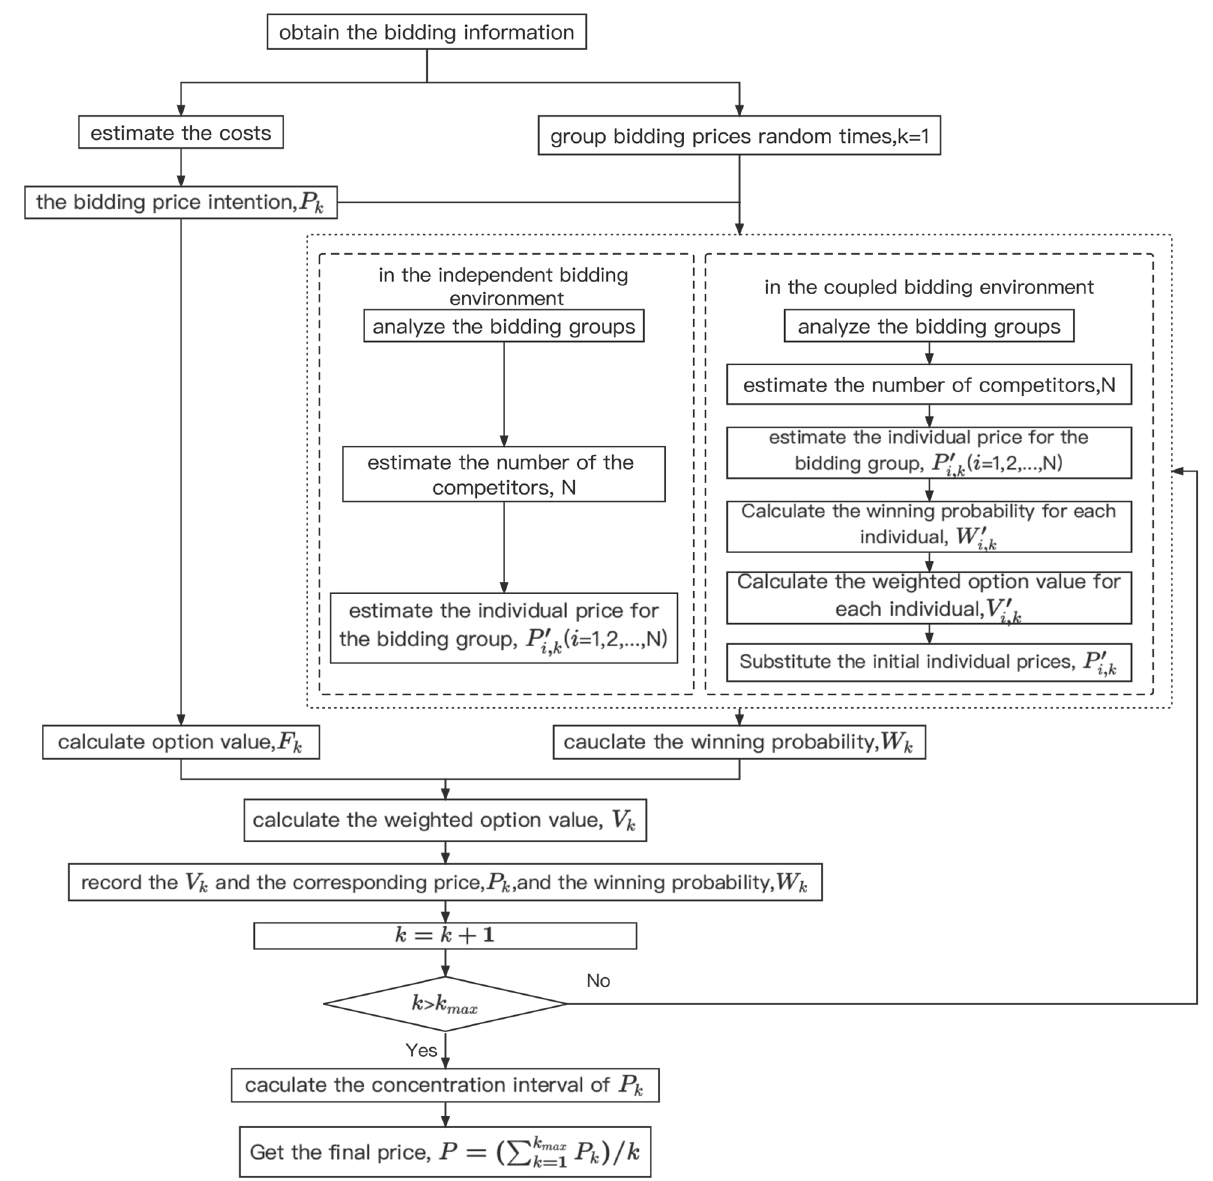
Figure 1. The real option pricing decision